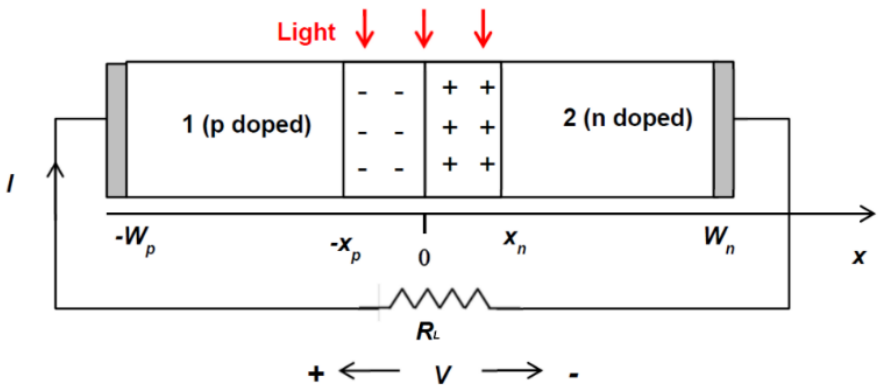
Figure 2. PN junction of a solar cell [15].